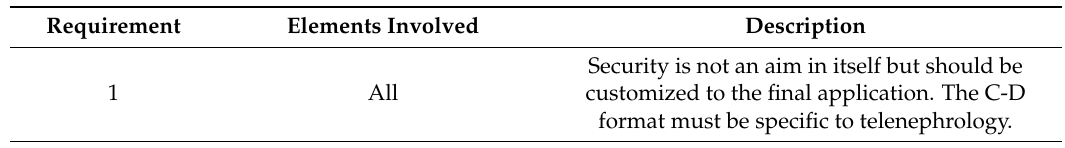
Table 2. Analysis of which elements in the new security manager address each User-Centered security requirement that has been